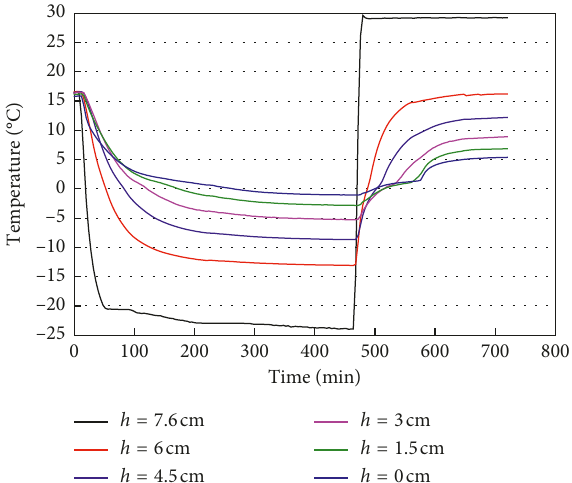
Figure 4: Variation of temperature and deformations of specimen with